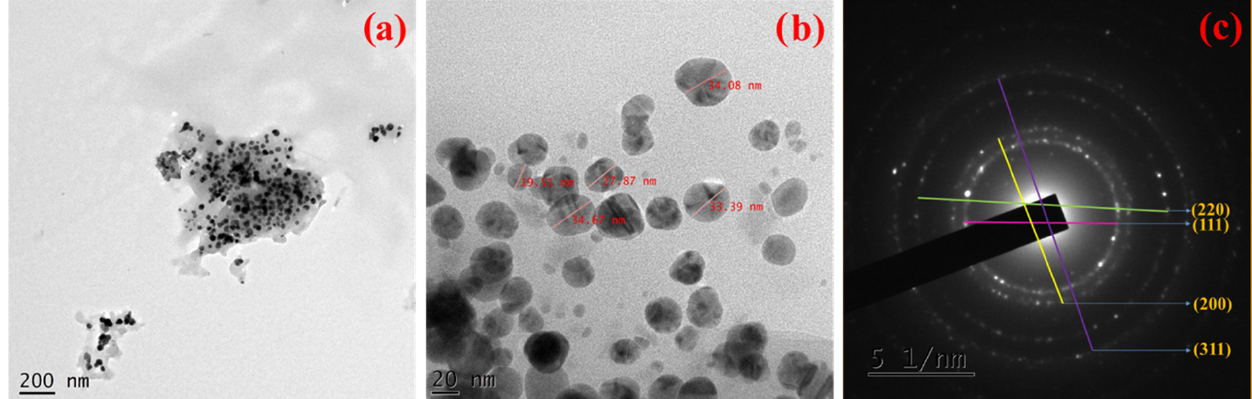
Figure 4. Morphology and crystalline pattern of green synthesized Ag NPs: ( a , b ) HRTEM images, and ( c ) SAED pattern.